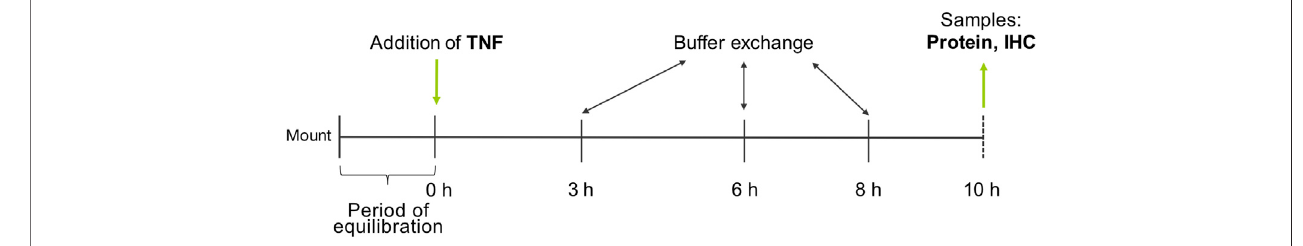
FIGURE 1 | Experimental